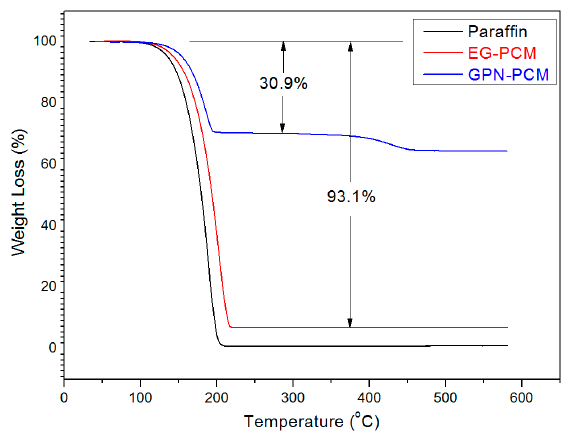
Figure 8. TGA thermograms of the paraffin and CPCMs.